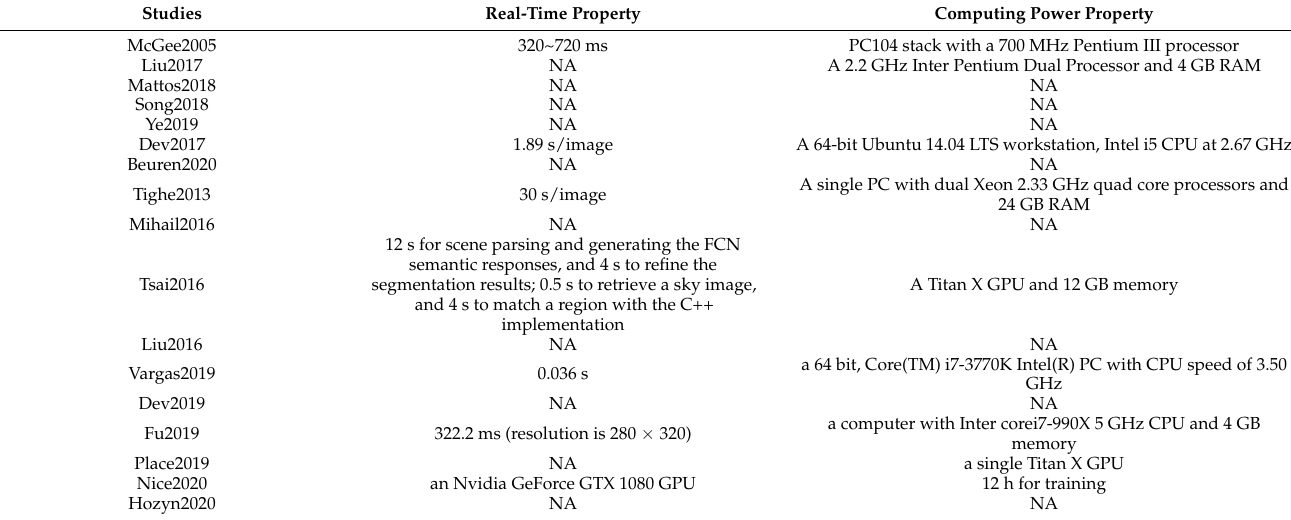
12 s for scene parsing and generating the FCN semantic responses, and 4 s to refine the segmentation results; 0.5 s to retrieve a sky image, and 4 s to match a region with the C++ implementation